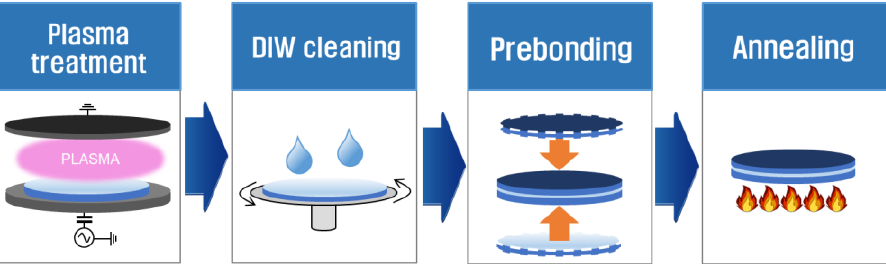
Figure 2. Sequence of the wafer bonding process.